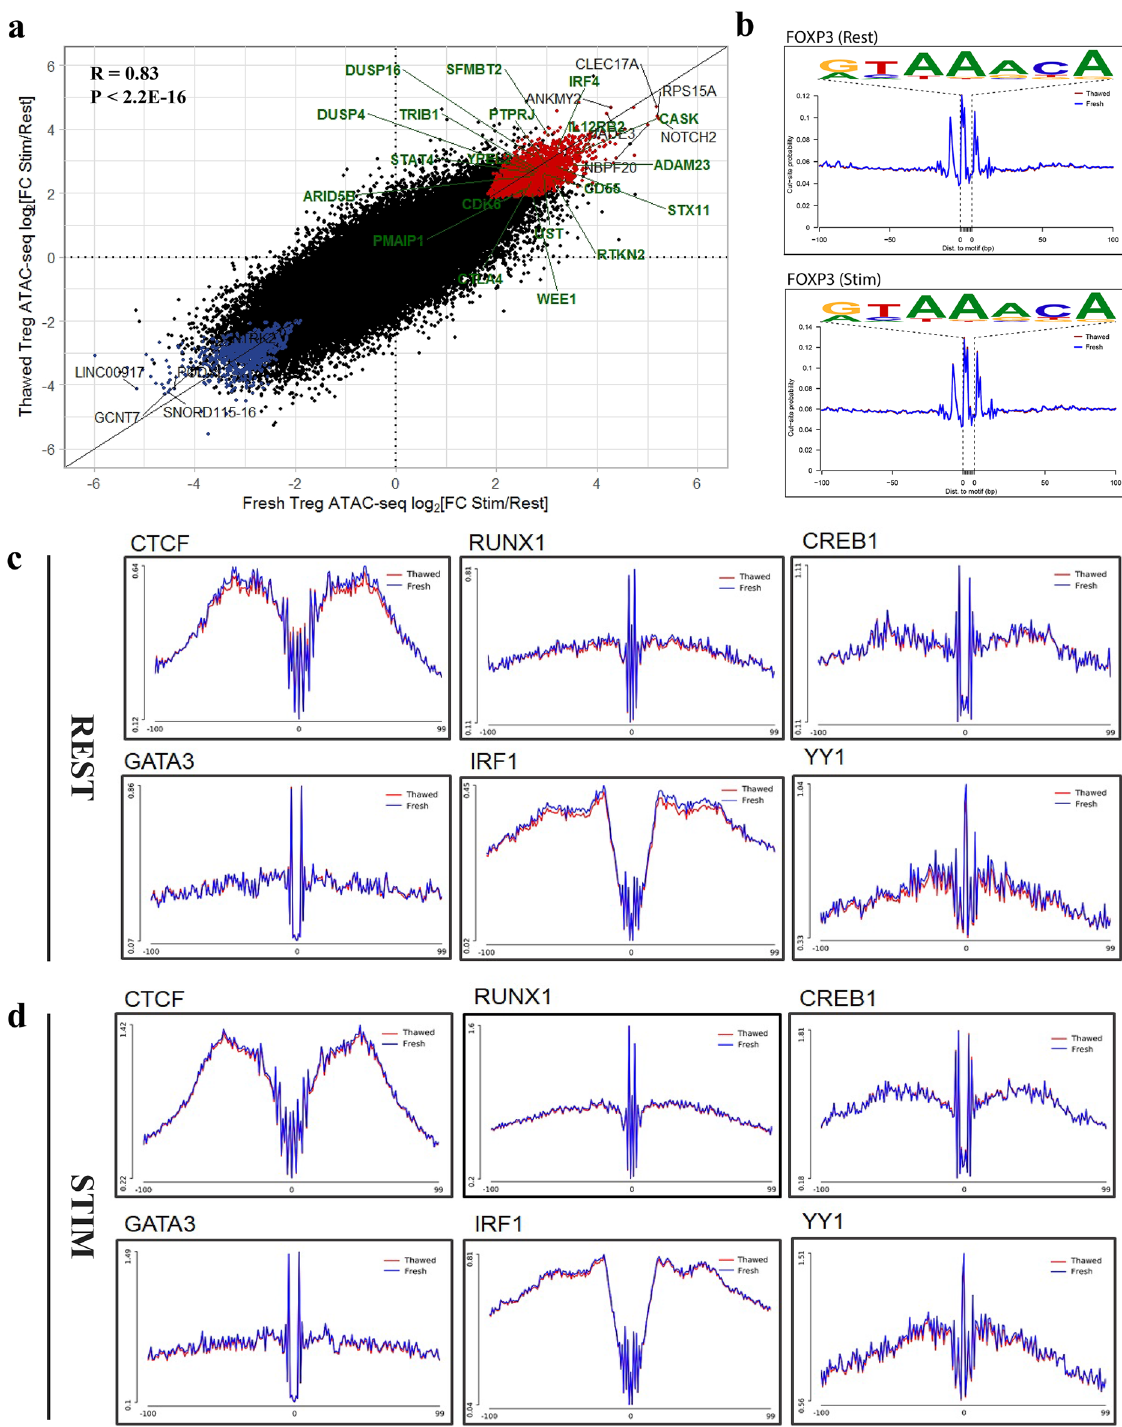
Figure 4. Thawed Treg cells demonstrate comparable TF activity to fresh cells. ATAC-seq was performed on sorted resting and stimulated fresh and thawed Treg cells. ( a ) Correlation of stimulation-responsive chromatin accessibility changes in fresh and thawed Treg cells (expressed as fold changes in reads in peaks between resting and stimulated states). Differentially accessible genomic loci between resting and stimulated states were defined as genes having an FDR of less than 0.05 and log-fold change that is significantly greater (red) or lower (blue) than 1.2 (equivalent to a 2.3-fold difference between conditions). ATAC-seq peaks were annotated to the nearest TSS and common differentially accessible peaks with a log-fold change that is significantly greater/lower than 4 are annotated by gene symbol. Top 20 common differentially accessible Treg signature genes (Ferraro et al. 37 ) are highlighted in green. ( b–d ) Histogram comparing fragments from fresh and thawed samples at FOXP3 ( b ), CTCF, RUNX1, CREB1, GATA3, IRF1 and YY1 binding motifs during resting ( c ) and stimulated ( d ) states. TF occupancy signal is computed on the genome-wide ATAC-seq footprints matching the corresponding motifs obtained from JASPAR database. Histograms are generated from Treg chromatin accessibility signals computed from pooled sequencing data representative of three